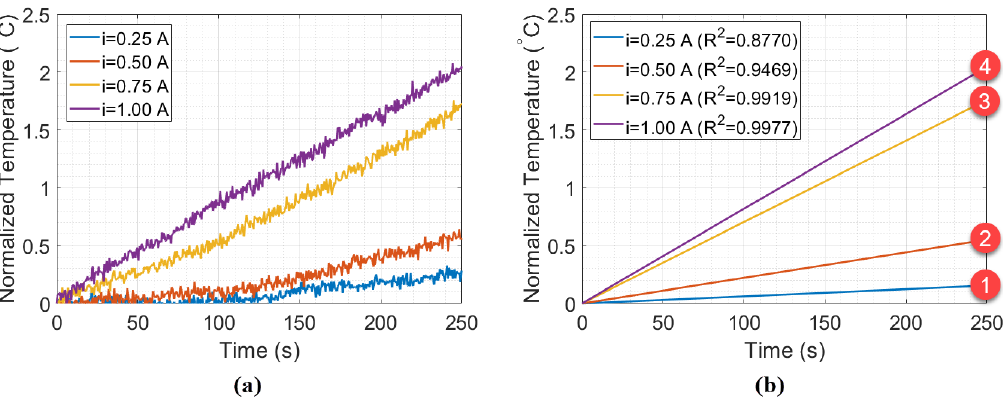
Figure 6. ( a ) Experimental data measured in the beaker experiment, for i p = 0.25 Ã, i p = 0.5 Ã, i p = 0.75 Ã, and i p = 1 Ã with ( b ) their respective fitting curves.